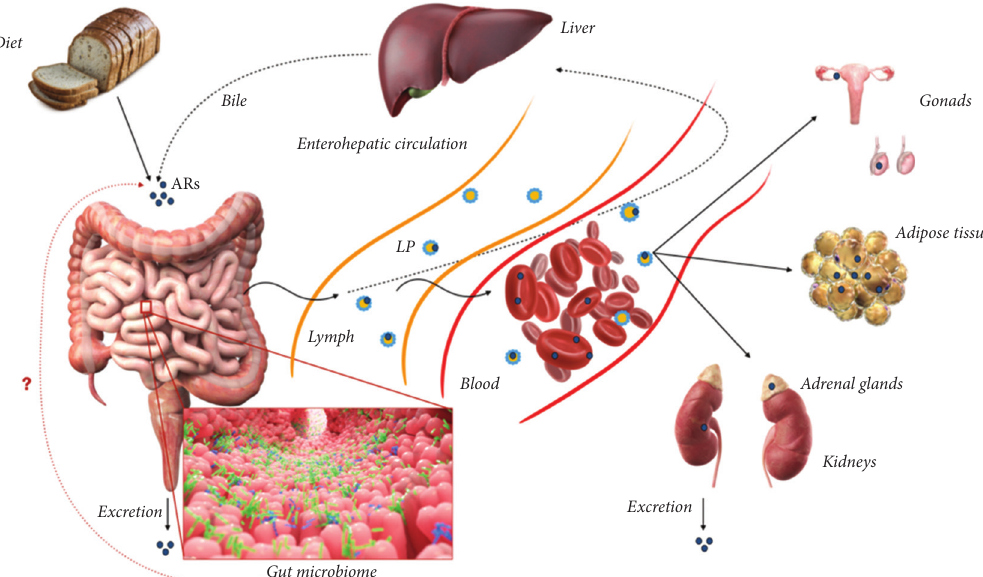
Figure 3: ARs absorption and metabolism. ARs enter the human body mainly with whole grain products, although gut microbiome origin of ARs is also possible. ARs are transported through the lymph and blood as a part of lipoproteins (LP) toward the liver and other tissues. ARs are metabolized in the liver and excreted through the kidneys with urine or through the intestine with